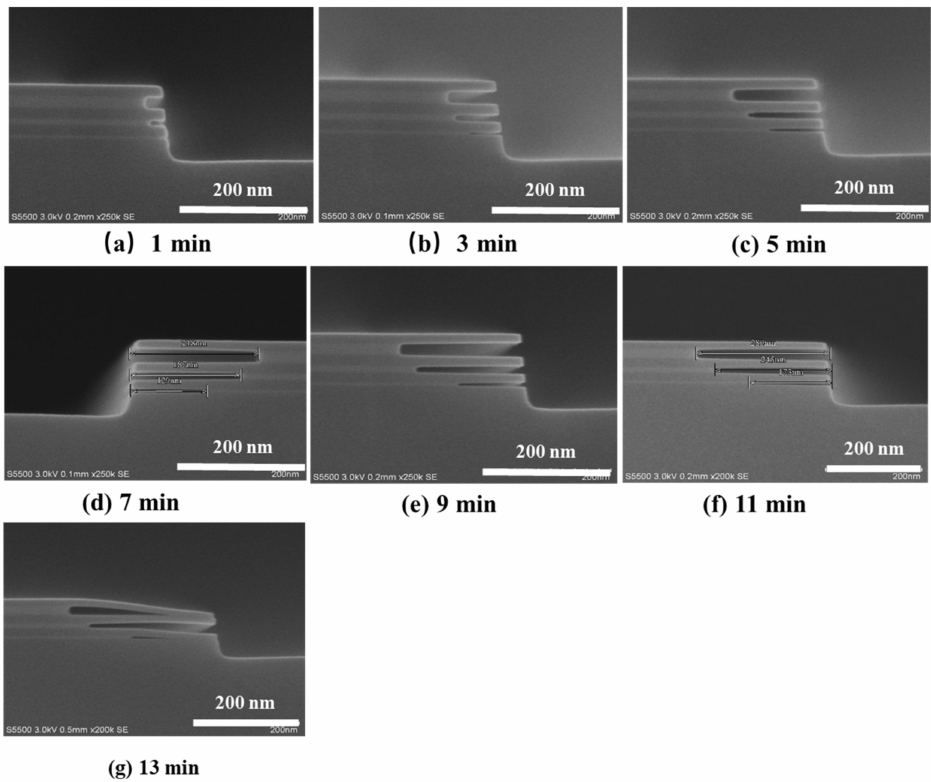
Figure 2. Scanning electron microscopy (SEM) images of GeSi/Si stacks after different etching times: ( a ) 1 min, ( b ) 3 min, ( c ) 5 min, ( d ) 7 min, ( e ) 9 min, ( f ) 11 min, and ( g ) 13 min,